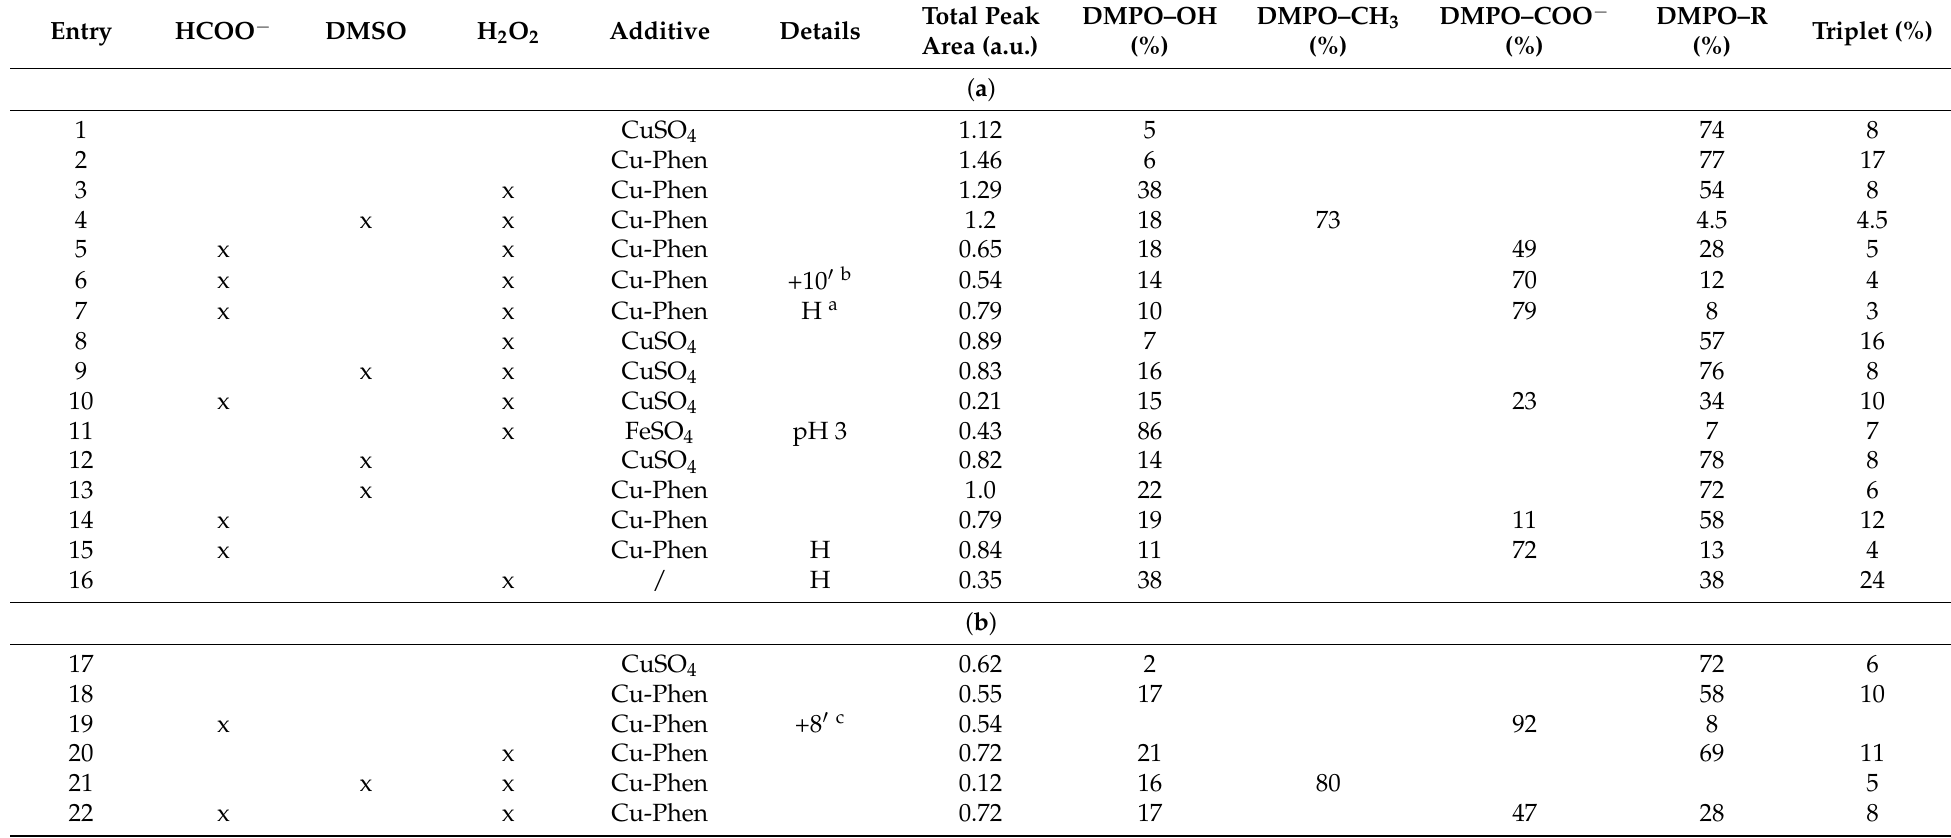
Table 1: ( a ) Integration and simulation results at near-neutral pH: total peak area, and distribution of DMPO adducts and degradation products for some experiments, as relative areas of each radical, in percent. ( b ) Integration and simulation results at alkaline pH (with NaOH): total peak area, and distribution of DMPO adducts and degradation products for some experiments, as relative areas of each radical, in